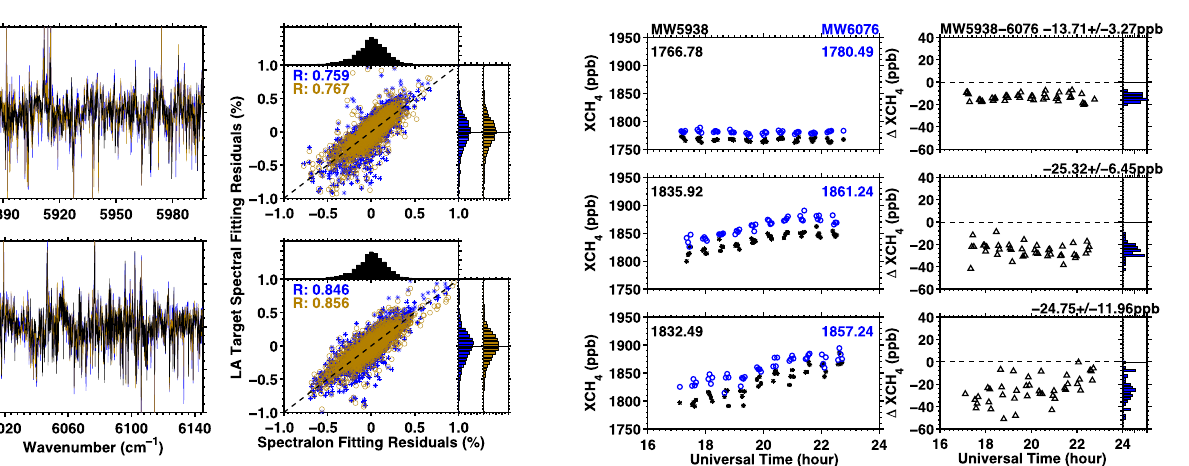
Figure 11 . XCH 4 (in parts per billion (ppb)) measured by CLARS-FTS with MW5938 (black dots) and MW6076 (blue circles) on January 3 rd , 2013 (left panels) and differences of retrieved XCH 4 between the two spectral regions and the histograms (right panels) in the Spectralon viewing geometry (top panels), towards the Arcadia Race Track (middle panels); and towards west Pasadena (bottom panels). Black stars in left panels: XCH 4 obtained using the spectral region of MW5938. Compared to the background levels of XCH 4 (top panels), XCH 4 over Arcadia Race Track (middle panels) and west Pasadena (bottom panels) show higher values (mean ART-SV: 74.95 ppb; mean WP-SV: 71.23 ppb) and present stronger diurnal cycles than those measurements over CLARS site. The XCH 4 values retrieved from MW6076 are higher than those of MW5938. The mean differences between MW6076 and MW5938 are 13.71 ppb, 25.32 ppb, and 24.75 ppb for SV, ART and WP respectively. These systematic differences of retrieved XCH 4 values between two spectral bands likely arise from the discrepancies of spectroscopic parameters between two spectral bands and the amount/intensity of spectral features of interfering species.